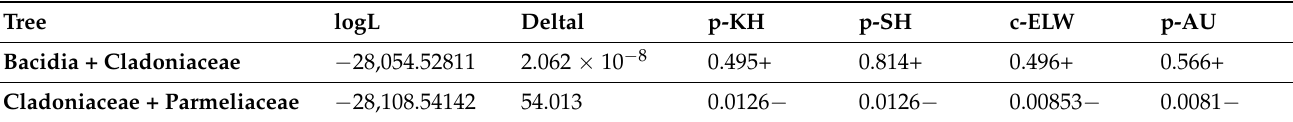
Table 3. Parameters for the topology test. Topology 1, recovering Bacidia + Cladoniaceae as mono- phyletic; Topology 2, recovering Cladoniaceae + Parmeliaceae as monophyletic. Value for the Kishino–Hasegawa test (Kishino and Hasegawa, 1989), Shimodaira and Hasegawa, 1989), expected likelihood weights (Strimmer and Rambaut, 2002) and approximately unbiased (AU) test (Shimodaira, 2002) are